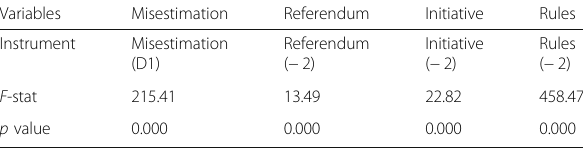
Table 6 Validity of the instruments (2SLS First stage F-stat)